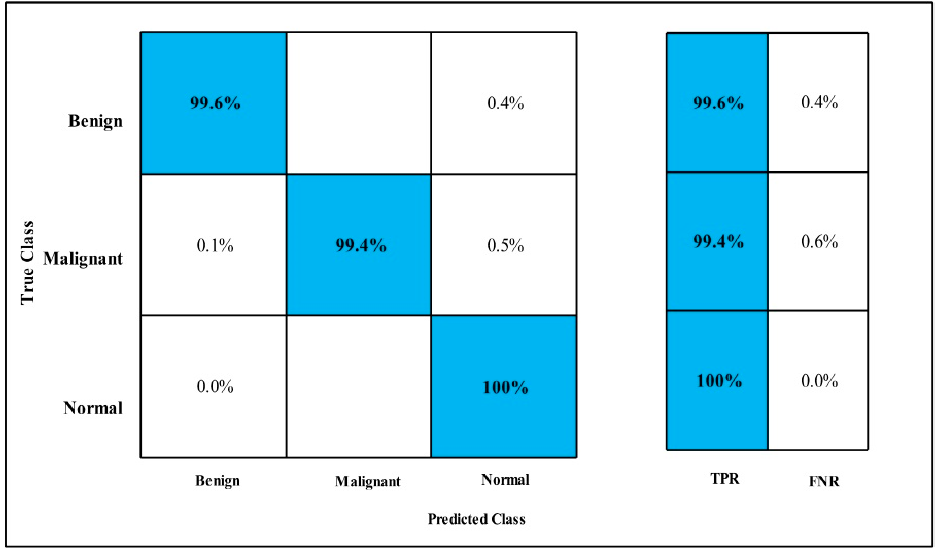
Figure 18. Fusion TPR for MIAS.